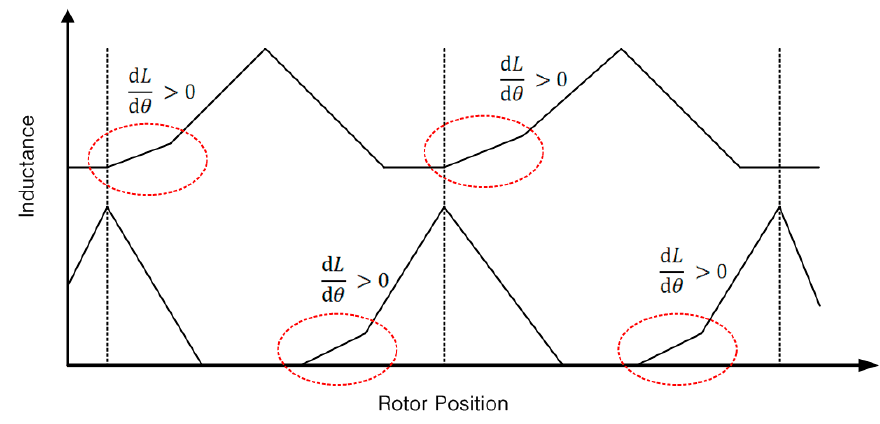
Figure 7. Non ‐ uniform air gap inductance graph of the proposed two ‐ phase 4/2 pole SRM.